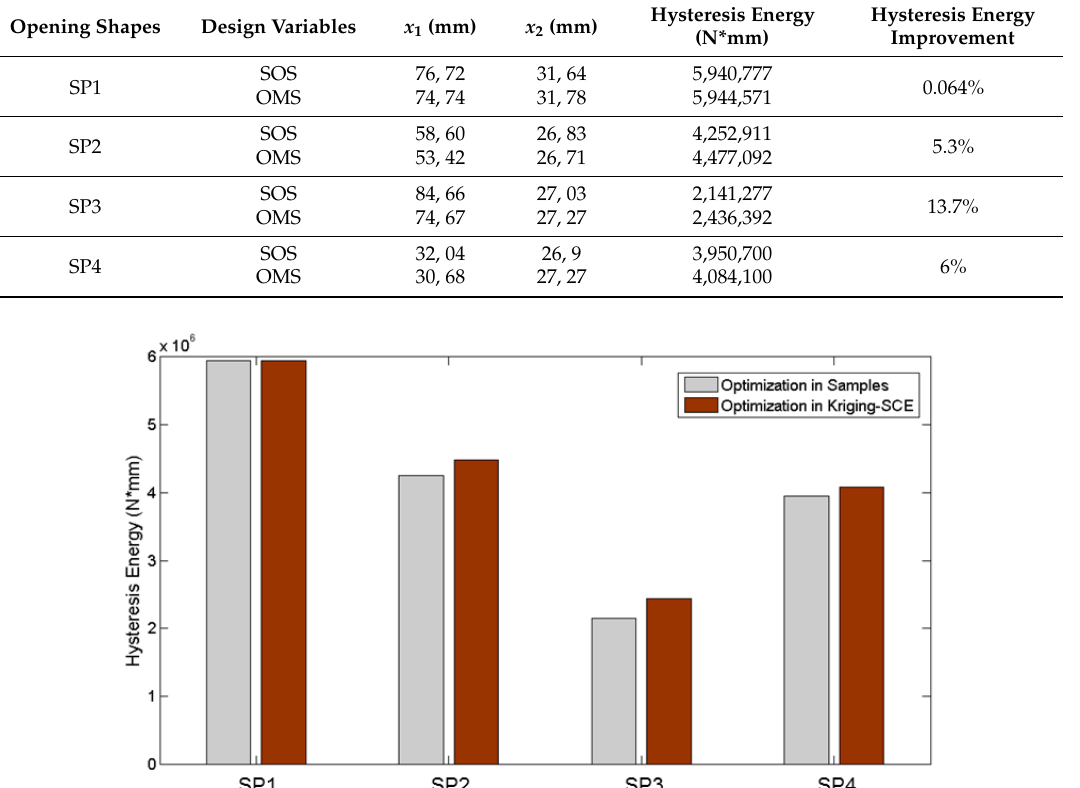
Figure 7. Hysteresis energy of four kinds of optimized coupling beam metal dampers. Table 1. Optimization results f or sample optimal solution (SOS) and optimization model solution (OMS).